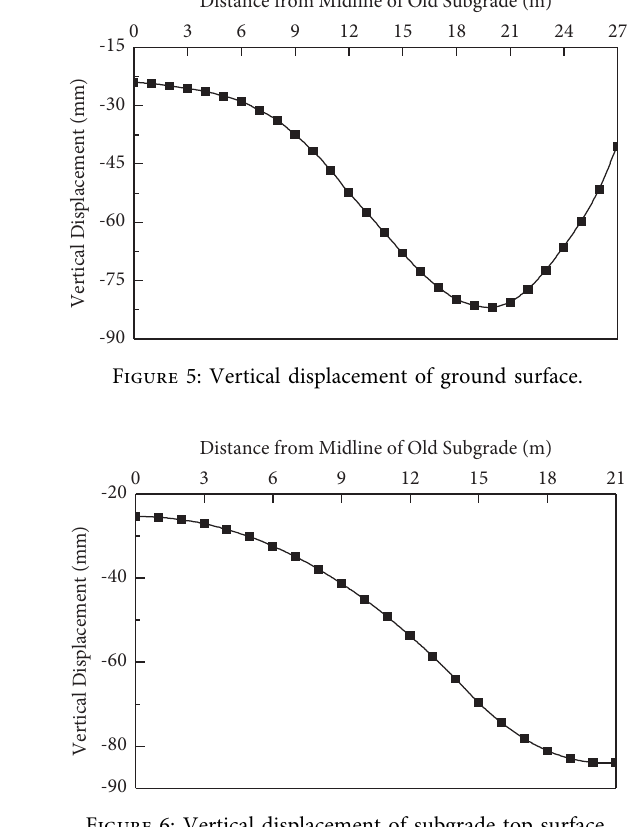
Figure 6: Vertical displacement of subgrade top